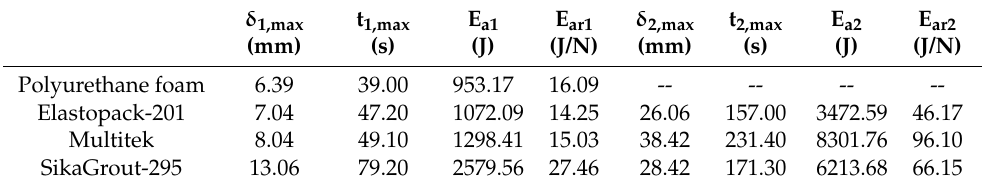
Table 5. Values obtained for the absolute strain energy (E a ) and the strain energy relative to weight (E ar ) in cycles 1 and 2 with the values of displacement ( δ ) and time (t) at each of the maximum loads of each cycle. δ 1,max δ 2,max t 1,max E a1 E ar1 t 2,max E a2 E ar2 (mm) (s) (J) (J/N) (mm) (s) (J) (J/N) Polyurethane foam 6.39 39.00 953.17 16.09 -- -- -- -- Elastopack-201 7.04 47.20 1072.09 14.25 26.06 157.00 3472.59 46.17 Multitek 8.04 49.10 1298.41 15.03 38.42 231.40 8301.76 96.10 SikaGrout-295 13.06 79.20 2579.56 27.46 28.42 171.30 6213.68